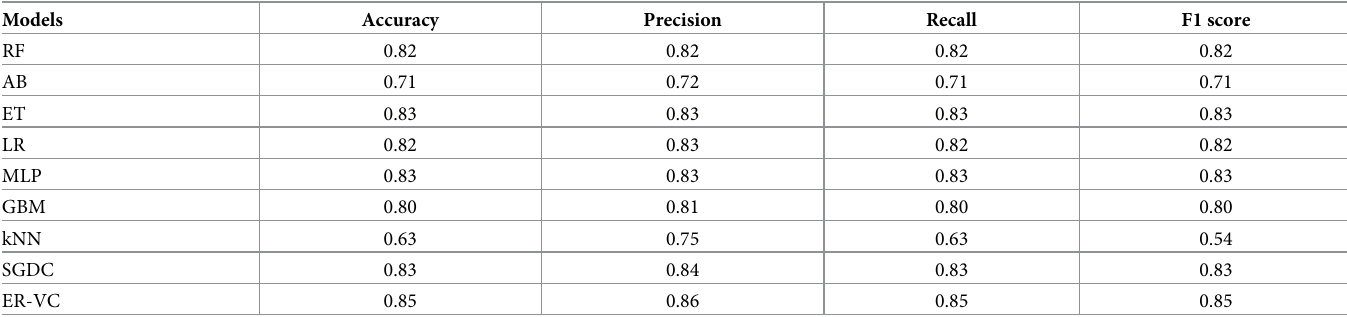
Table 9. Classification results of machine learning models using TF-IDF with ADASYN. Models